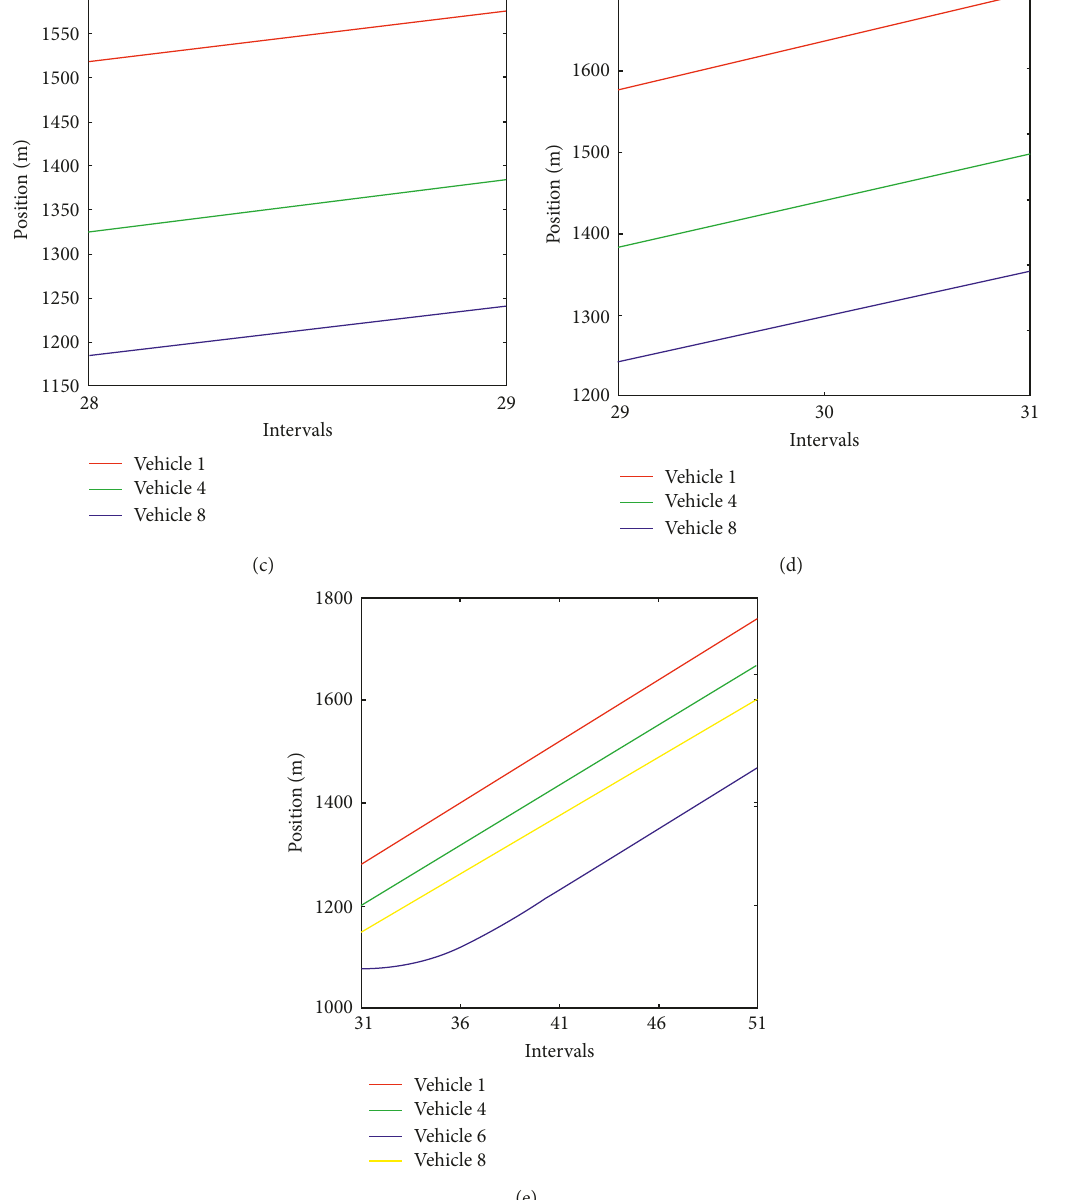
Figure 8: Comparison of vehicle trajectories on lane 1: (a) 2–8s, (b) 8–56 s, (c) 56–58s, (d) 58–62 s, and (e)